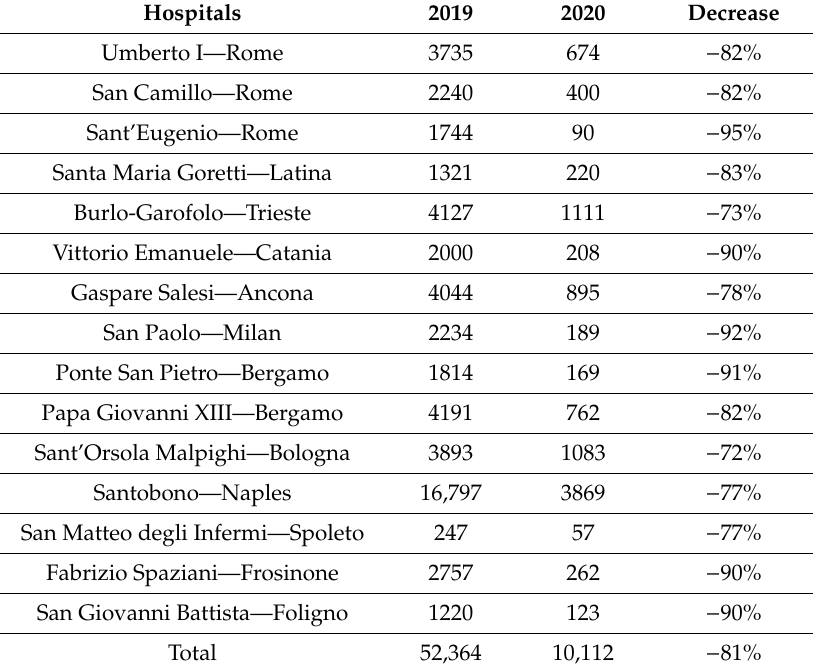
Table 1. ER admissions reduction between 9 March and 3 May 2019, and the same period in 2020.